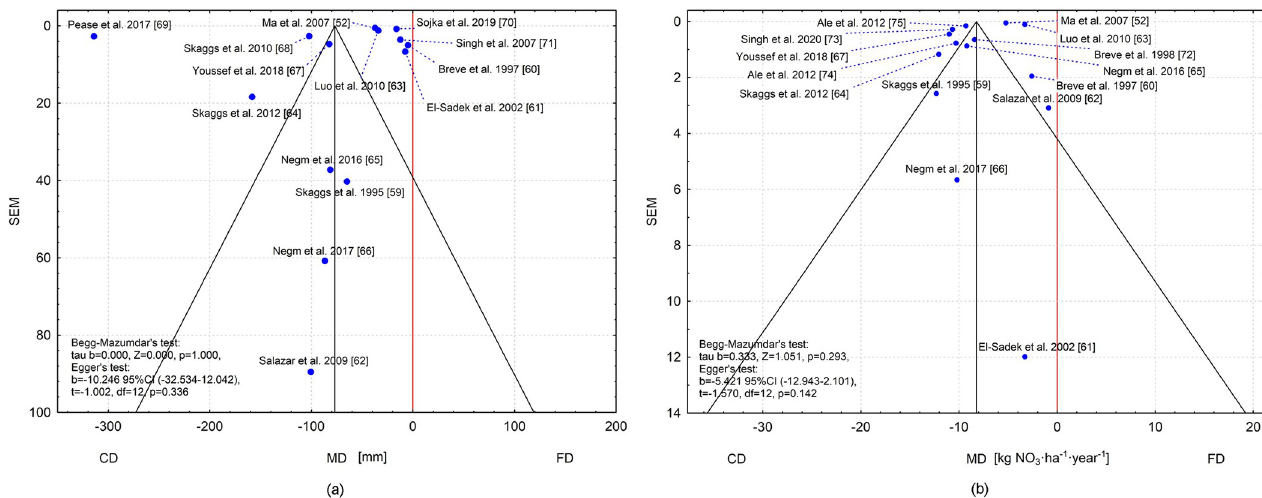
Fig 8. Funnel plot (from Begg-Mazumdar test) for publication bias: (a) subsurface drainage outflow reduction by CD versus FD; (b) nitrate load in drainage outflow by CD versus FD.